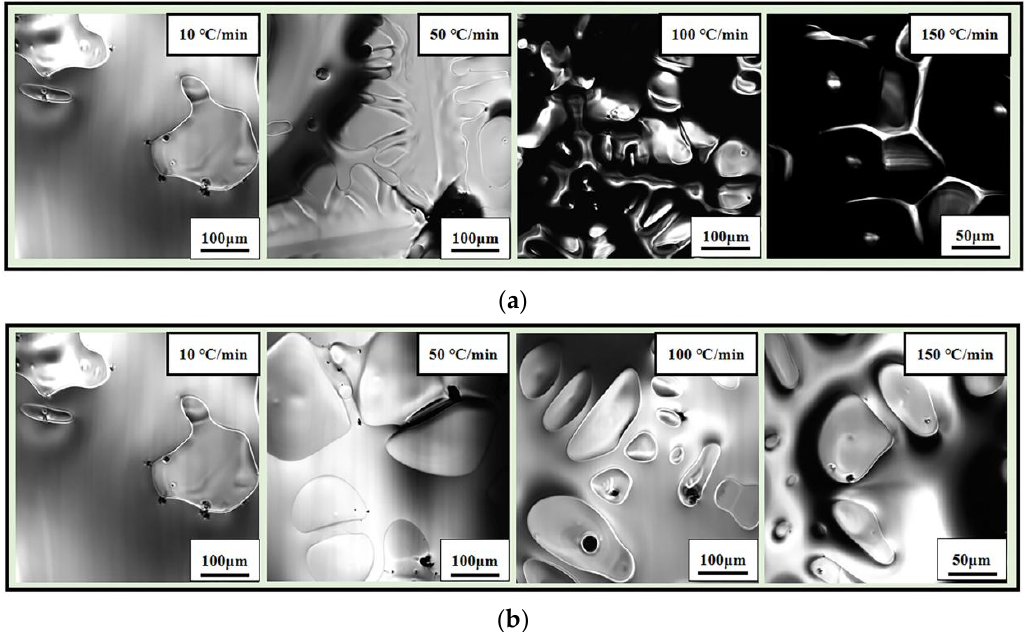
Figure 5. Microstructures of the studied 70 steel using HT-CSLM under different cooling rates at 1457 ◦ C. ( a ) Cooling rate was changed at the stage of the superheat elimination, ( b ) Cooling rate changed at the stage from liquidus to